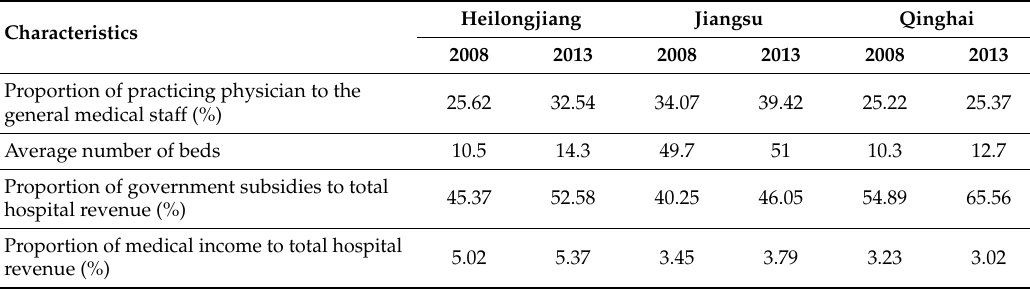
Table 2. Characteristics of township hospitals in sample areas.